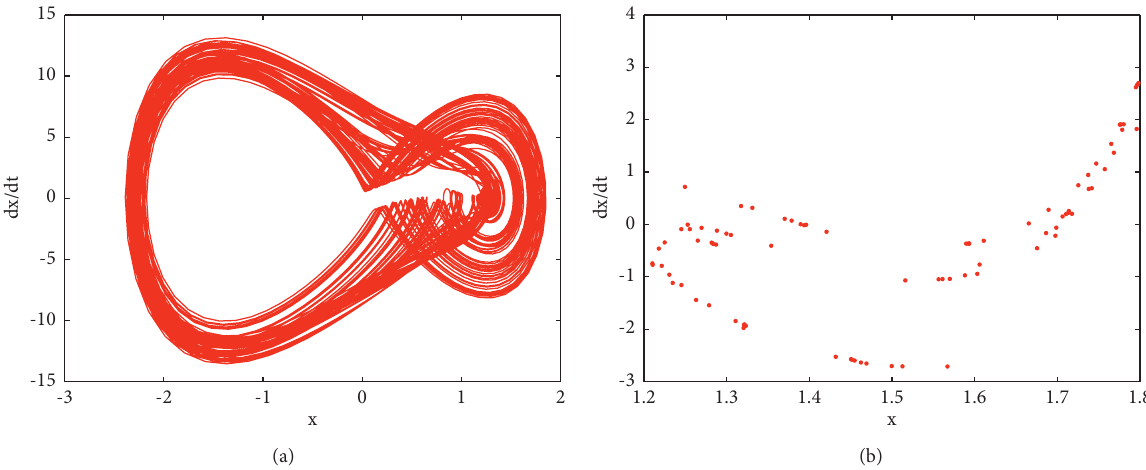
Figure 15: Phase portrait and Poincar´e cross section diagram of the system at F � 73.50 and τ � 0.8. (a) Phase portrait. (b) Poincar´e cross section diagram ( c � 0.5, c 1 � 30, c 2 � 20, μ � 0.001, k 1 � 10, and ω �